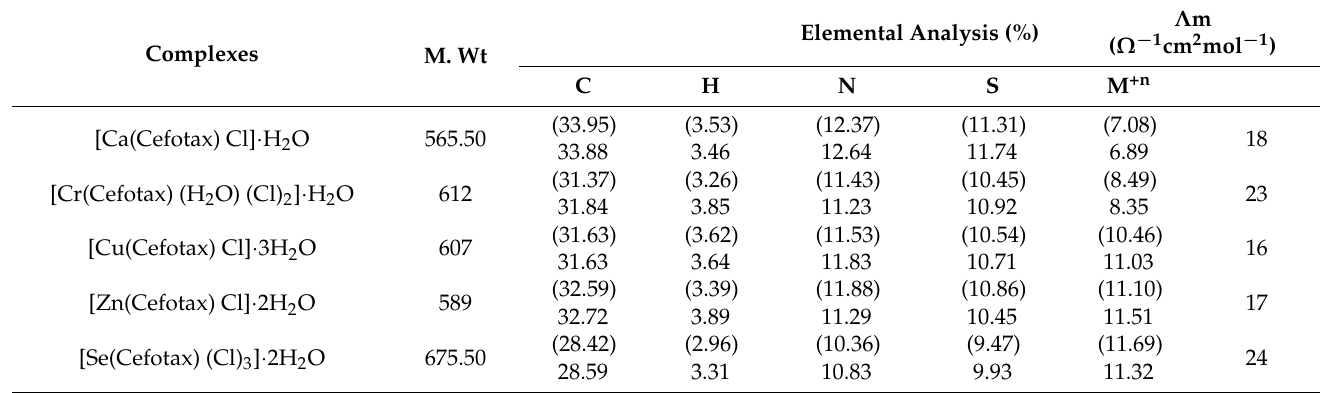
Table 1. Physical characterization and micro-analytical and molar conductance data of cefo- taxime